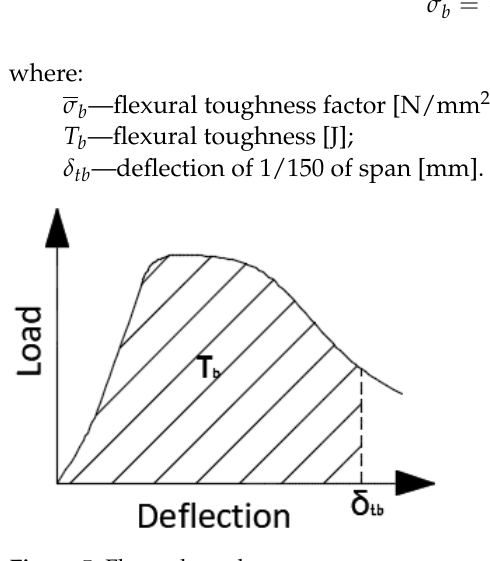
Figure 5. Flexural toughness. Figure 5. Flexural